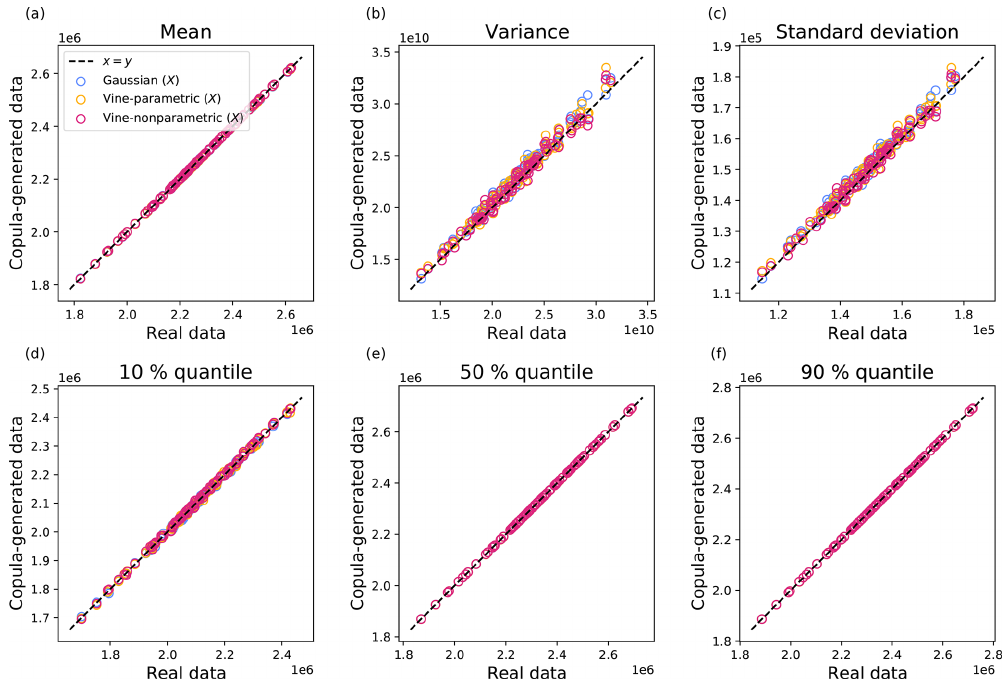
Figure 3. Summary statistics s i from 100 iterations for (a) mean, (b) variance, (c) standard deviation, and (d) 10%, (e) 50%, and (f) 90% quantiles. Each point corresponds to a statistic for a single iteration in arbitrary units. The x axis represents the projection of real NWP- SAF X train , while the y axis represents that of the copula-generated data X (cid:48) train . Results are reported for Gaussian, vine-parametric, and vine-nonparametric copulas (see legend for